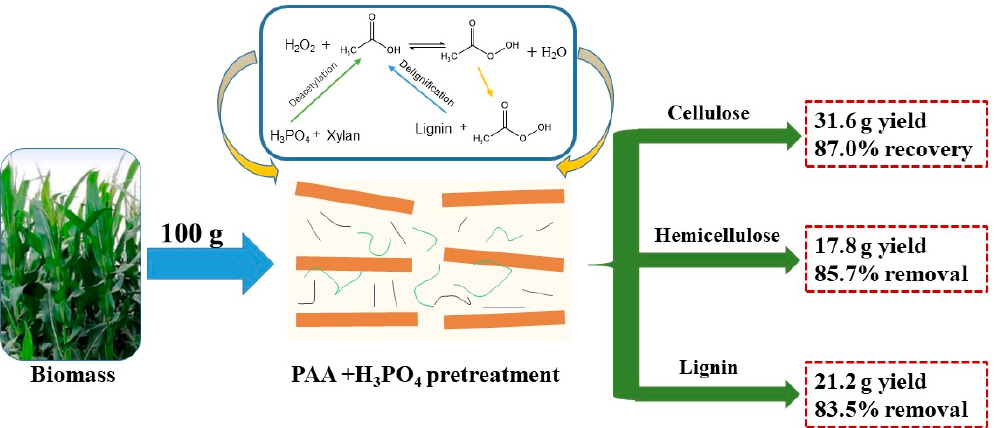
Figure 3. Self-generation of PAA in PHP (phosphoric acid plus hydrogen peroxide) system mediating overall deconstruction of lignocellulose and degradation of hemicellulose/lignin according to the data from reference [69].